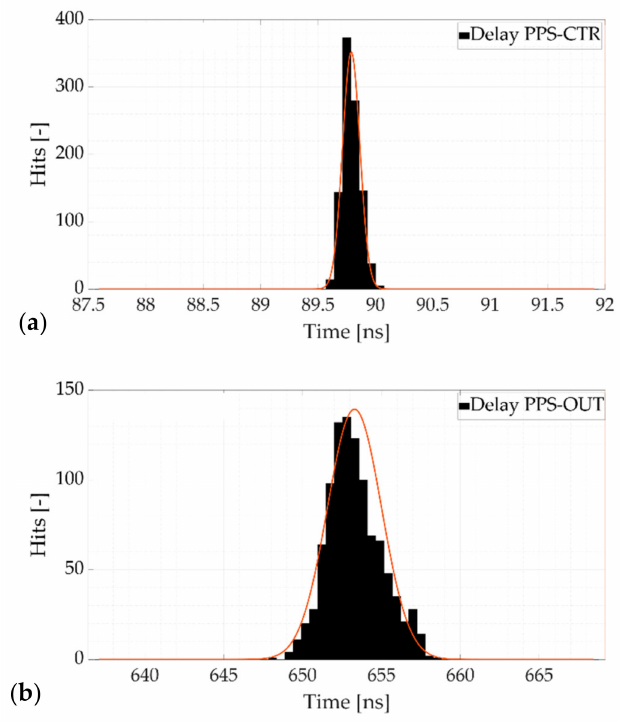
Figure 6. Distribution histograms of the delay measurement between the ( a ) PPS and the CTR rising fronts and ( b ) the PPS and the OUT rising